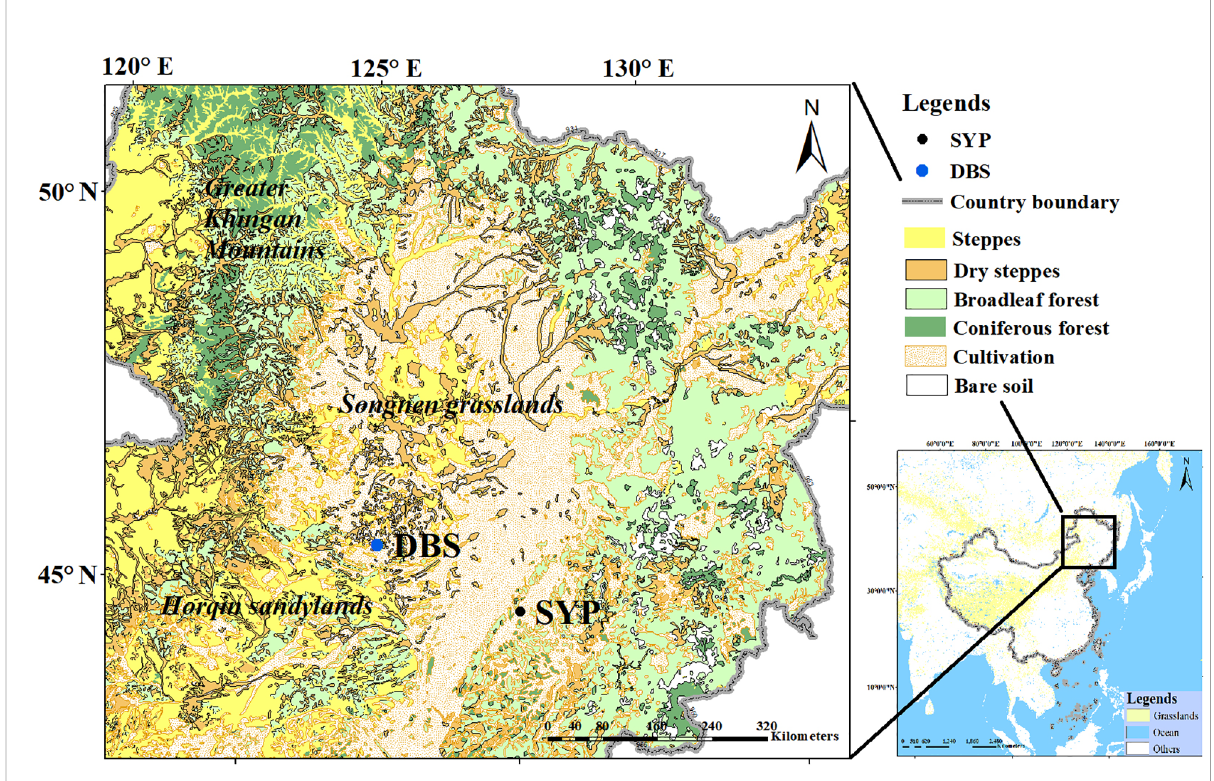
FIGURE 1 Present vegetation of the study area. The location of the pollen records used in this study are shown: Dabusu lake and peat sediments (DBS) and Shuangyang peatland sediments (SYP). Grassland cover at a continental scale appears in yellow on the map of China (right